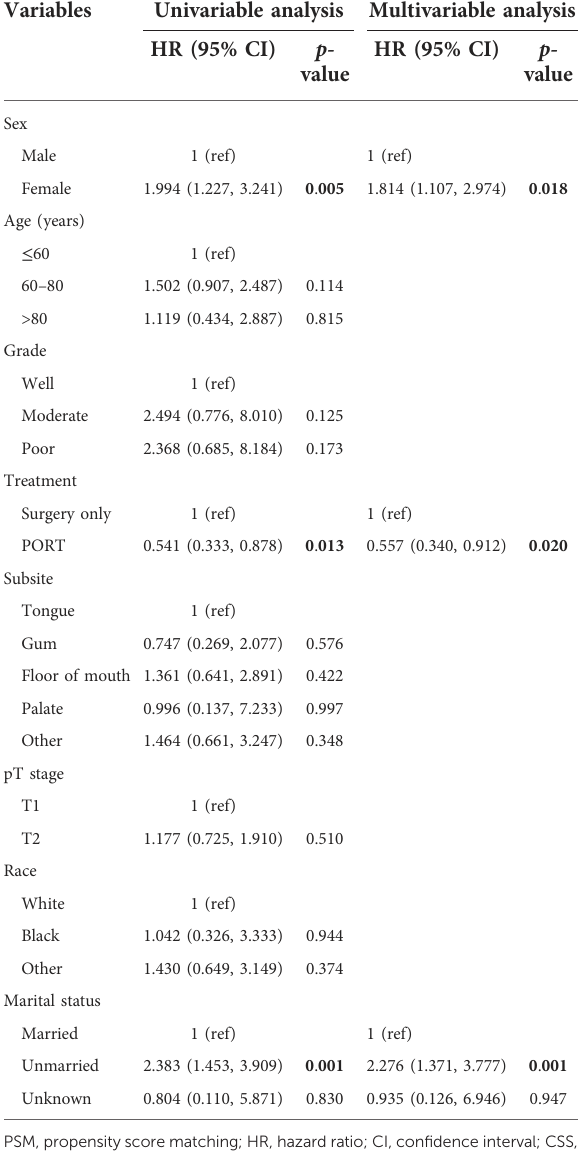
TABLE 3 Univariable and multivariable analyses of CSS by the Cox regression model (after PSM and lymph nodes examined ≤ 16).